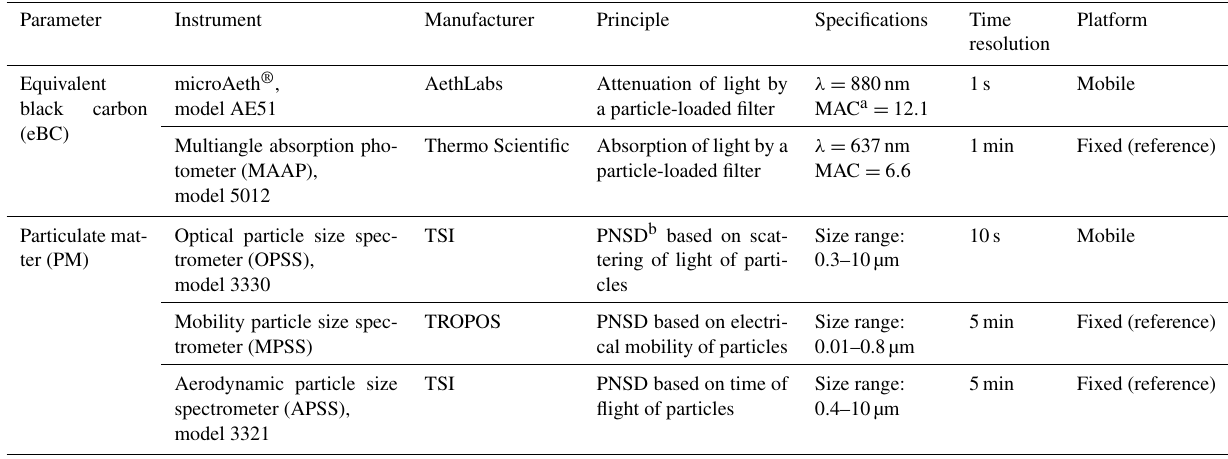
Table 1. Description of portable and reference instruments. Additional details are provided in Appendix